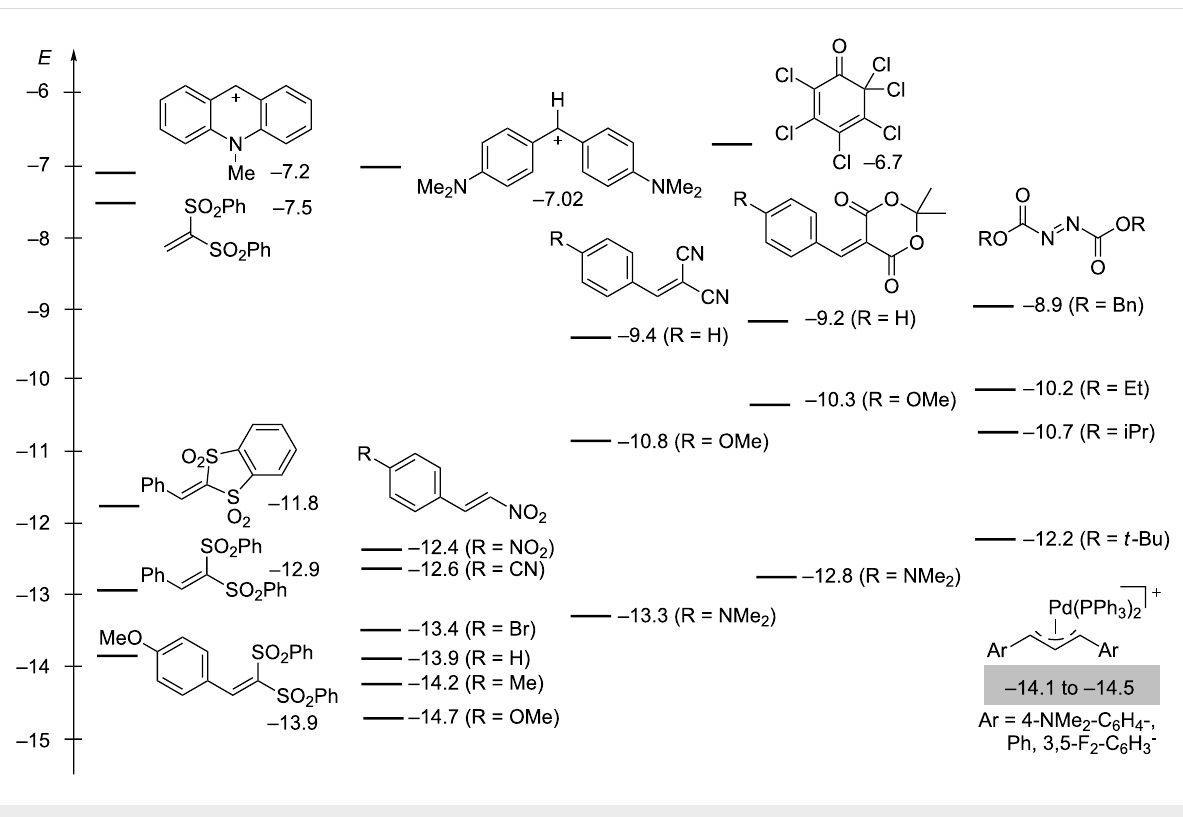
Figure 18: Electrophilicity parameters E for classes of compounds that have been used as electrophilic substrates in enamine activated reactions [4,73-80].